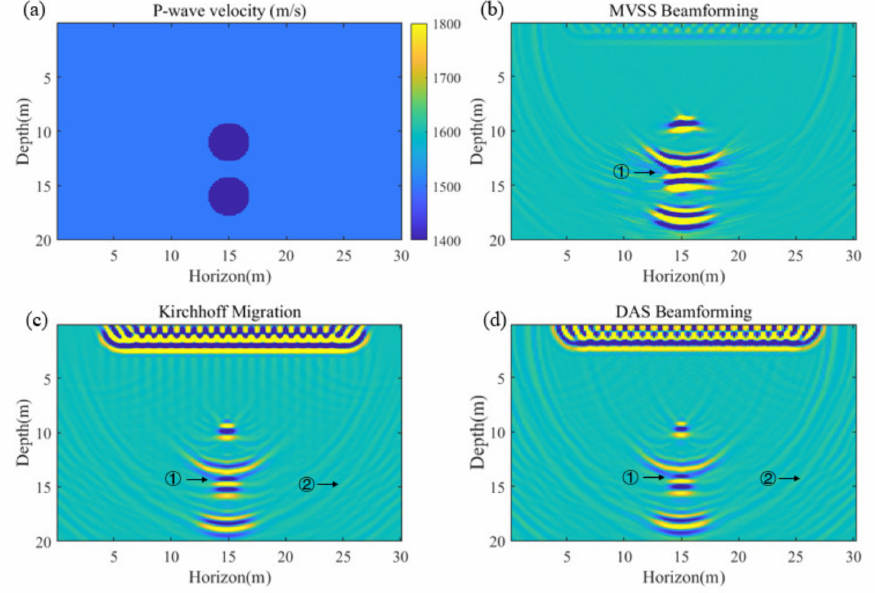
Figure 12. Model A-3. ( a ) True velocity model. ( b ) Imaging result of MVSS beamforming. ( c ) Imaging result of Kirchhoff migration. ( d ) Imaging result of DAS